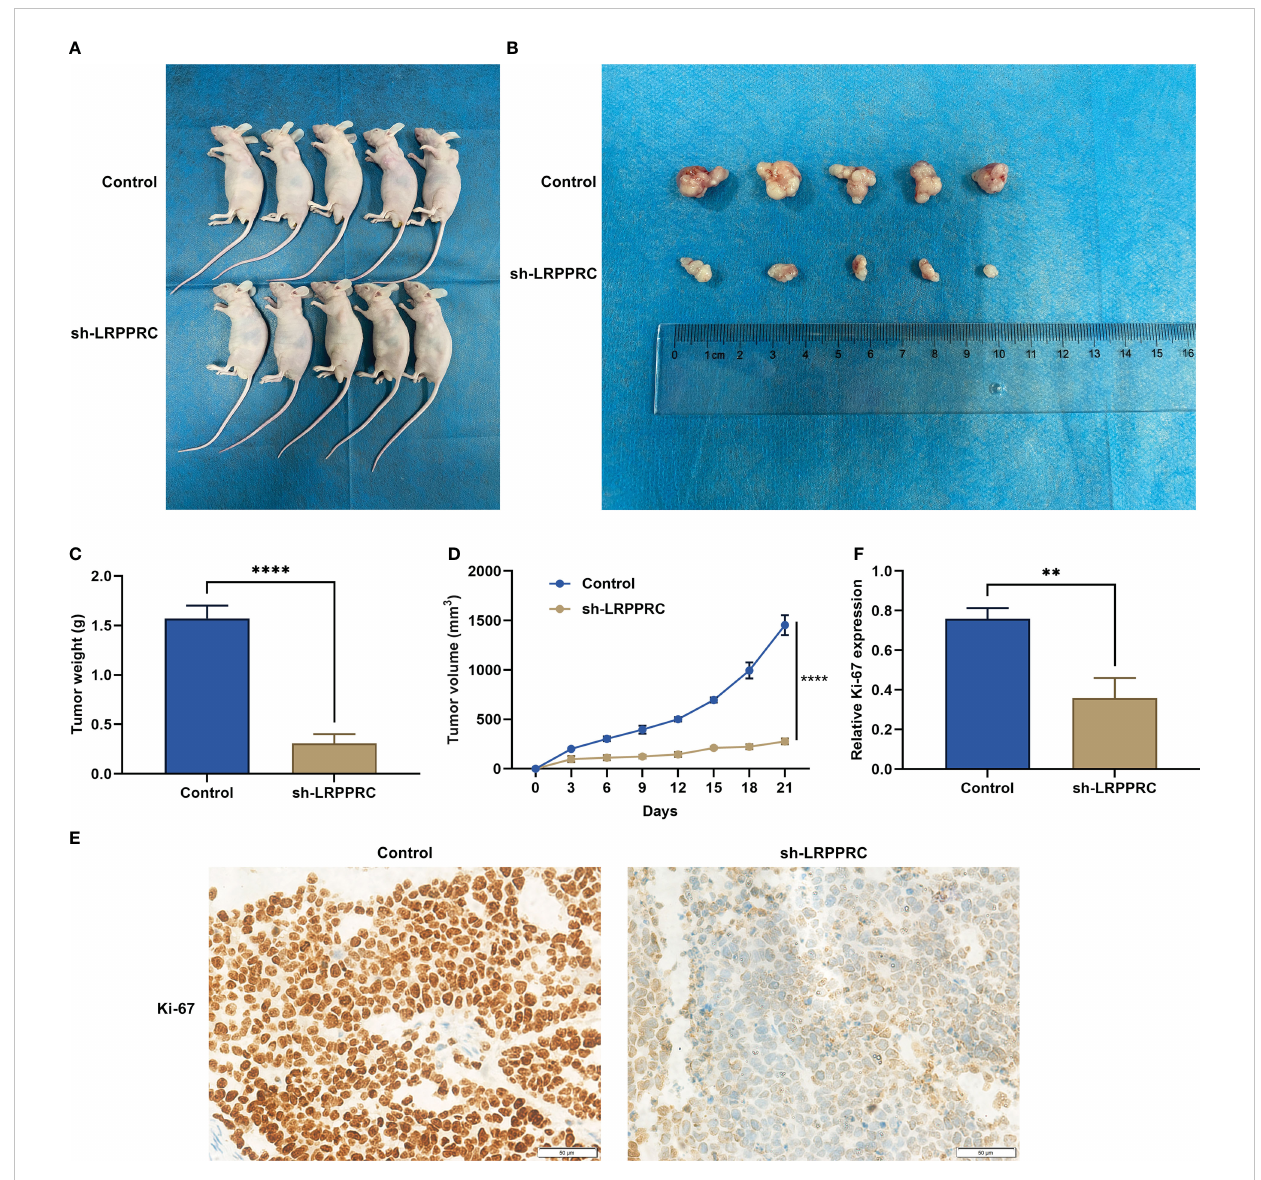
FIGURE 7 Leucine rich pentatricopeptide repeat containing (LRPPRC) suppression mitigates tumor growth in hepatocellular carcinoma (HCC). (A) Representative photographs of BALB/c nude mice injecting 2 × 10 5 HepG2 cells with LRPPRC knockout or not. (B) Representative photographs of tumors from the indicated BALB/c nude mice. (C , D) Tumor weight and tumor growth curves. (E , F) Representative photographs and quanti fi ed data of immunohistochemical staining of Ki-67 in tumors. Bar, 50 m m. ** p < 0.01; **** p <